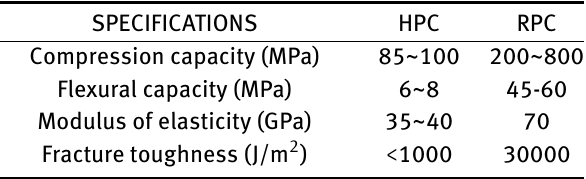
Table 1: Mechanical properties of RPC vs. HPC